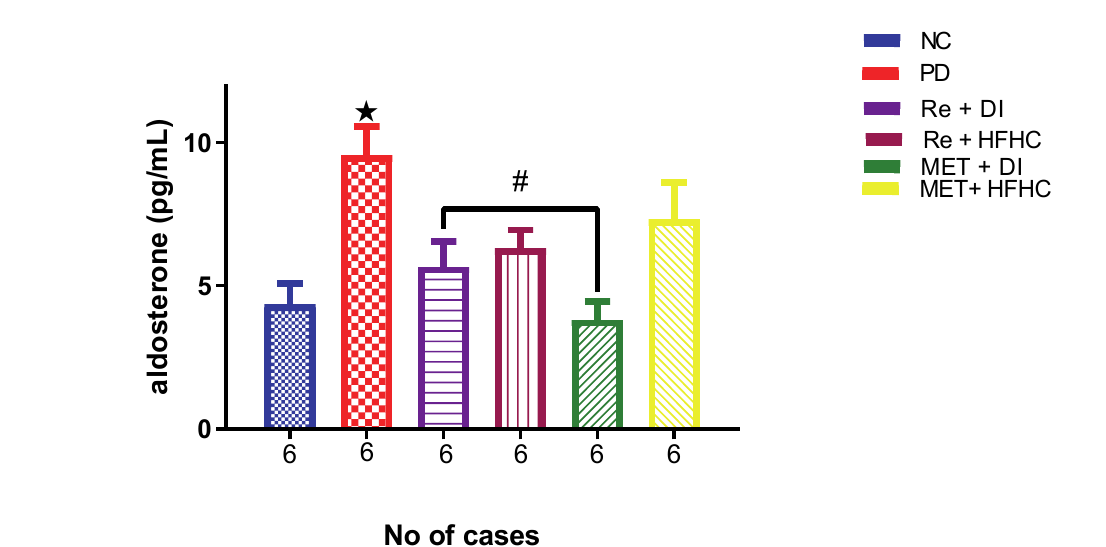
Figure 18. Plasma aldosterone concentration in normal control (NC), prediabetic control (PD), metformin and diet intervention (MET + DI), metformin and high-fat/high-carbohydrate diet (MET + HFHC), rhenium (V) compound and diet intervention (Re + DI) and rhenium (V) compound and high-fat/high-carbohydrate diet (Re + HFHC) groups after 12 weeks of treatment. Values are presented as means ± SEM (n = 6). (cid:70) p < 0.05 in comparison with NC; # p < 0.05 in comparison with PC, MET + DI, MET + HFHC, Re + DI and Re + HFHC.